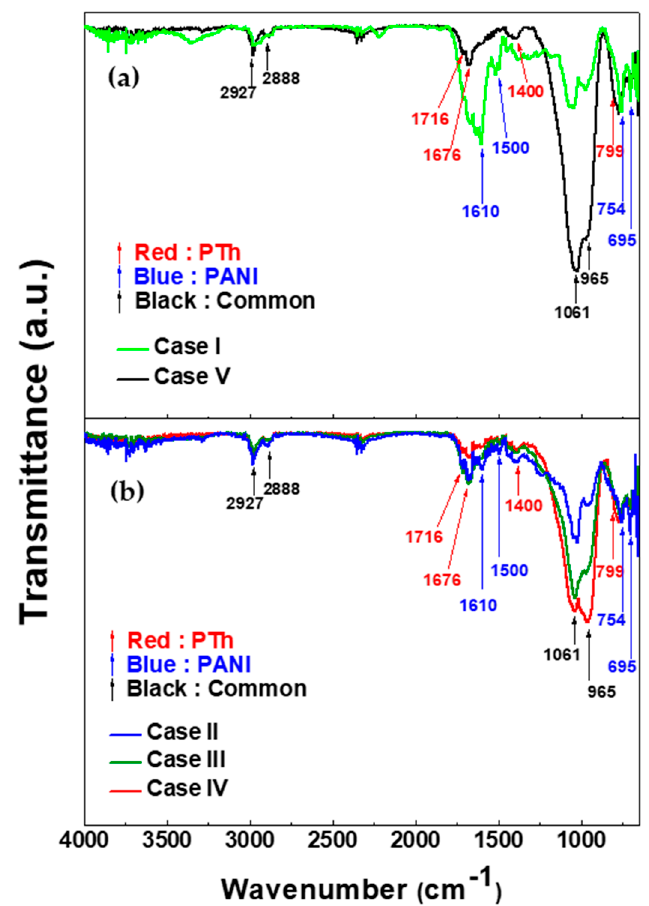
Figure 2. FT-IR spectra of ( a ) homopolymer films and ( b ) thiophene and aniline copolymer (TAC) films deposited on glass substrate by using atmospheric pressure plasma jets (APPJs) polymerization relative to various ratios of blended solutions of aniline and thiophene liquid monomer. Table 2. Absorption peaks of FT-IR for molecular structures of TAC films deposited on glass substrate relative to various ratios of blended solutions of aniline and thiophene monomers.